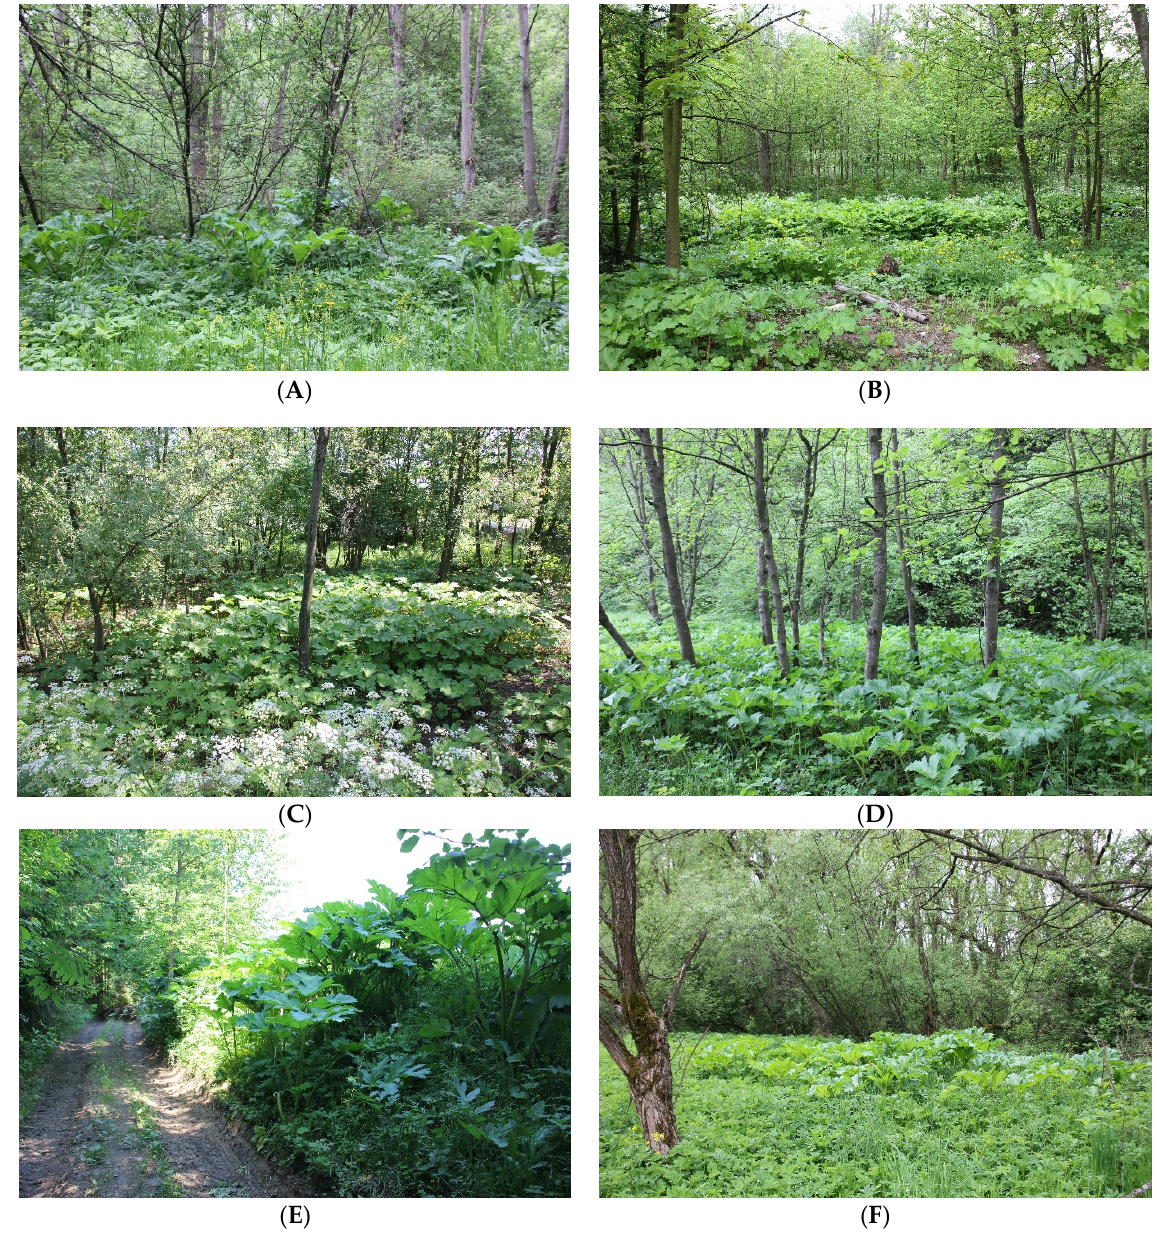
Figure 3. Examples of study sites with pre-flowering invading Sosnowsky’s hogweed in forested areas, photos ( A – D , F ) are from mid-May, photo ( E ) is from early June (author of photographs: E. Grz ę dzicka).